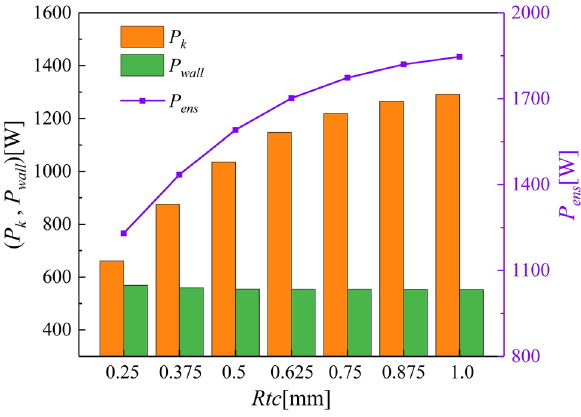
Figure 12. Variation in enstrophy dissipation power with tip